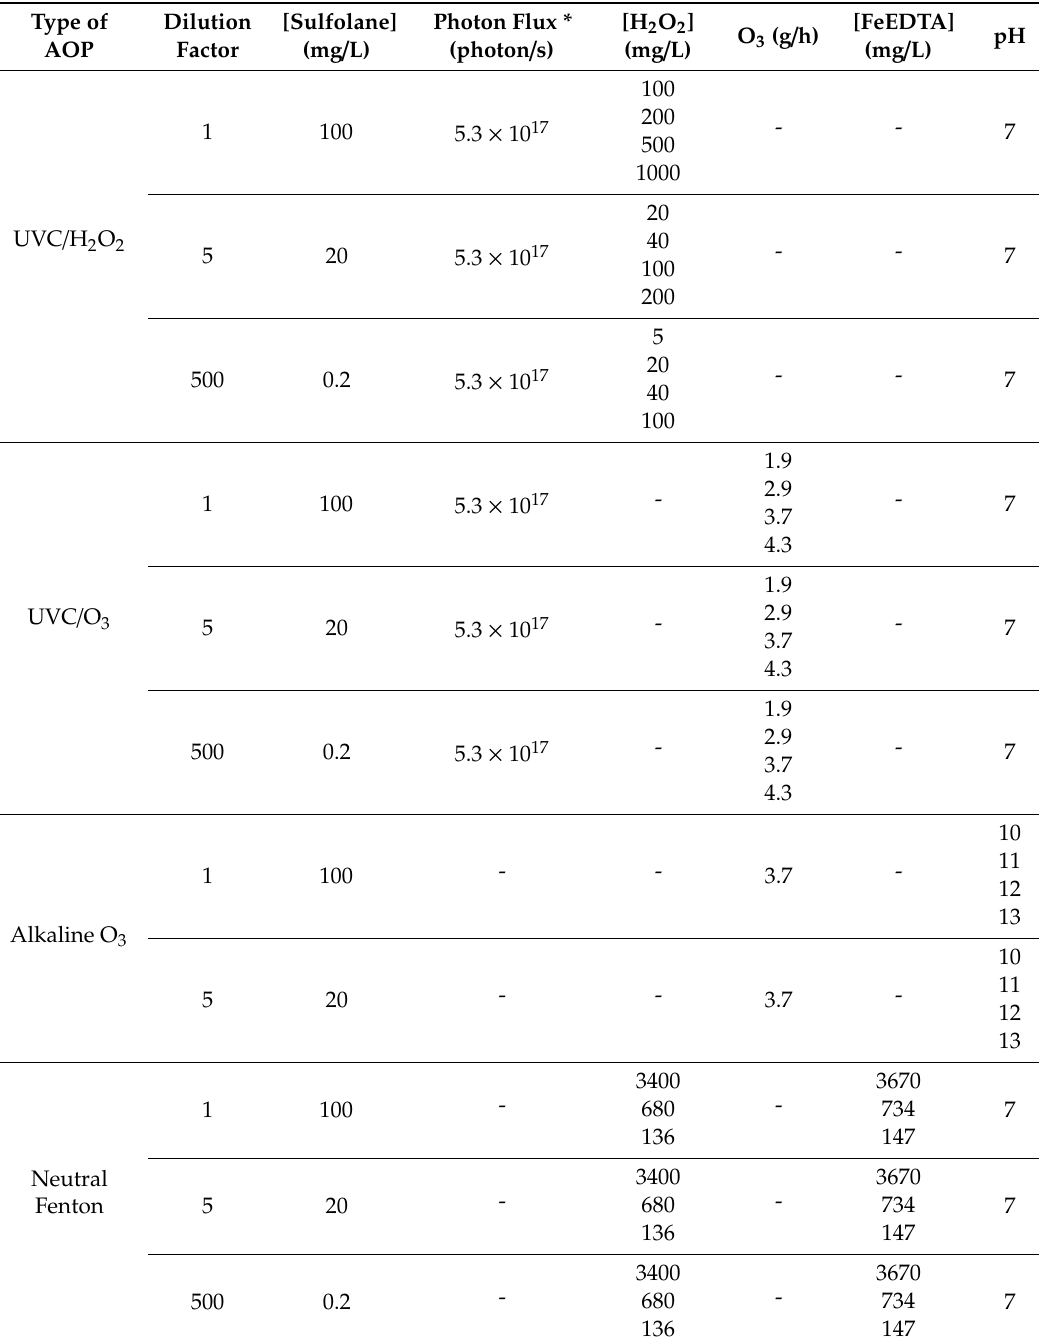
Table 2. Details of AOP